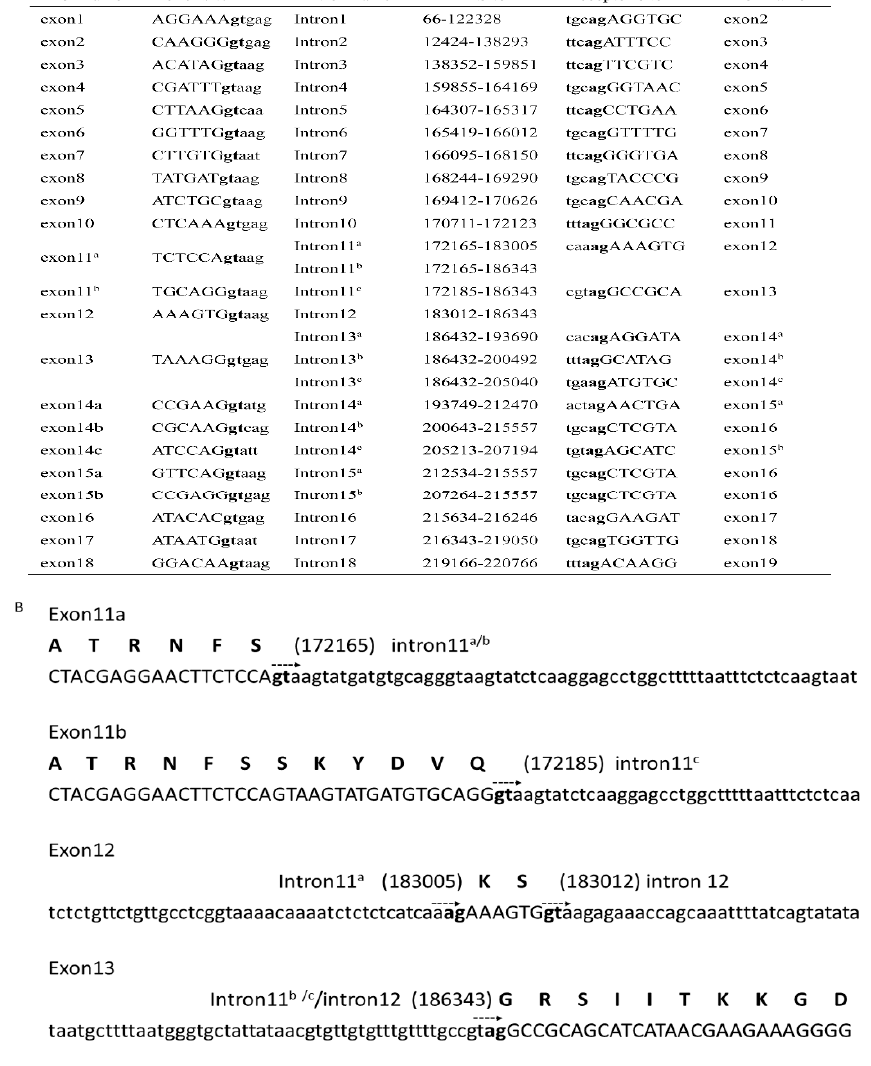
Figure 4. ( A ) Intron/exon organization of the NlCaMKII gene. ( B ) Differential splice sites in intron 11. Exon sequences are in capital letters, and intron sequences are shown in lowercase letters. Conserved gt and ag nucleotides are in bold lowercase letters. The arrows show the intron sequence direction from 5 ′ to 3 ′ . The corresponding sites in the genome of the intron start or stop are shown in parentheses. The amino acid sequences are shown in bold uppercase letters.